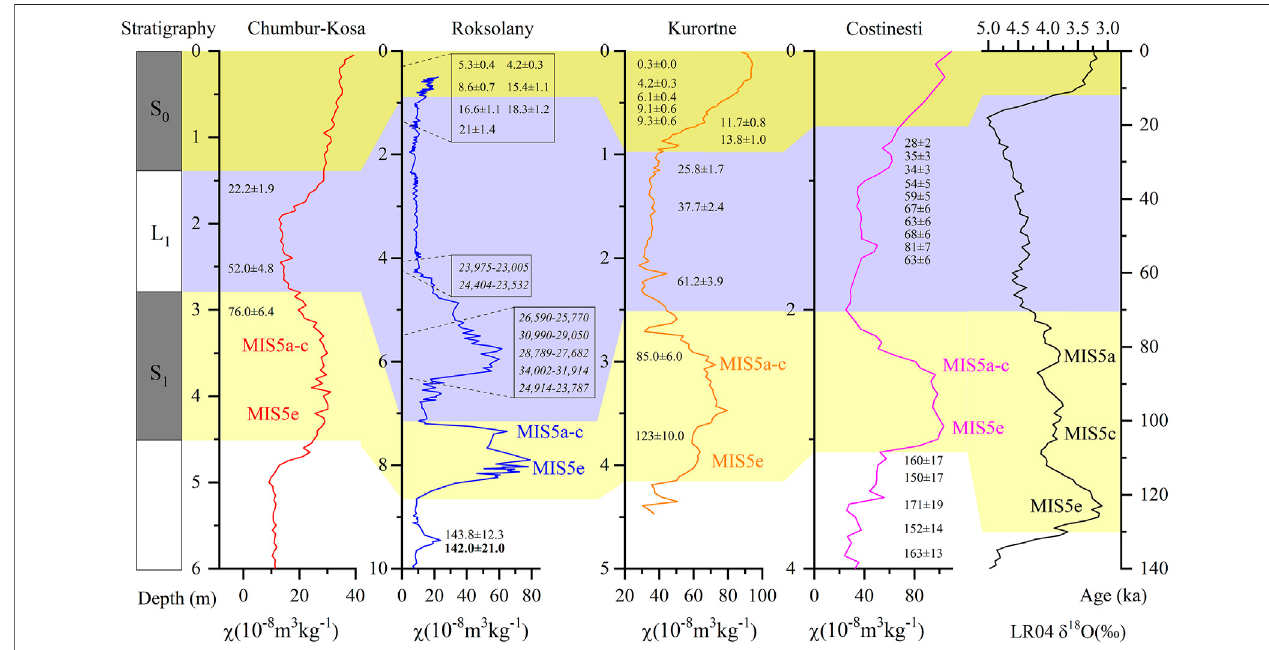
FIGURE9| StratigraphyoftheChumbur-Kosasectionanditscorrelationwithwell-datedloessrecordsneartheBlack – AzovSearegionbasedonthe χ lf proxy,and withthebenthicLR04stack.Roksolany,Ukraine(HlavatskyiandBakhmutov,2020);Kurortne,Ukraine(Tecsaetal.,2020);Costinesti,Romania(Constantinetal.,2014; Necula et al., 2015); and the benthic LR04 stack (Lisiecki and Raymo, 2005). Ages shown at the Chumbur-Kosa section are derived from Chen et al. (2018b); ages presented at the Roksolany section are cited from many references (Fedorowicz et al., 2012; Wulf et al., 2016; Constantin et al., 2019) and summarized in HlavatskyiandBakhmutov(2020);andagespresentedattheCostinestisectionarederivedfromConstantinetal.(2014).Notethattherearethreetypesofabsoluteages illustrated: ages in regular type represent OSL ages, ages in italic are 14 C ages, and ages in bold show TL ages. For more information, please see the main text in this study and related references. For location of sections near the Black – Azov Sea region, please refer to Figure 1 .